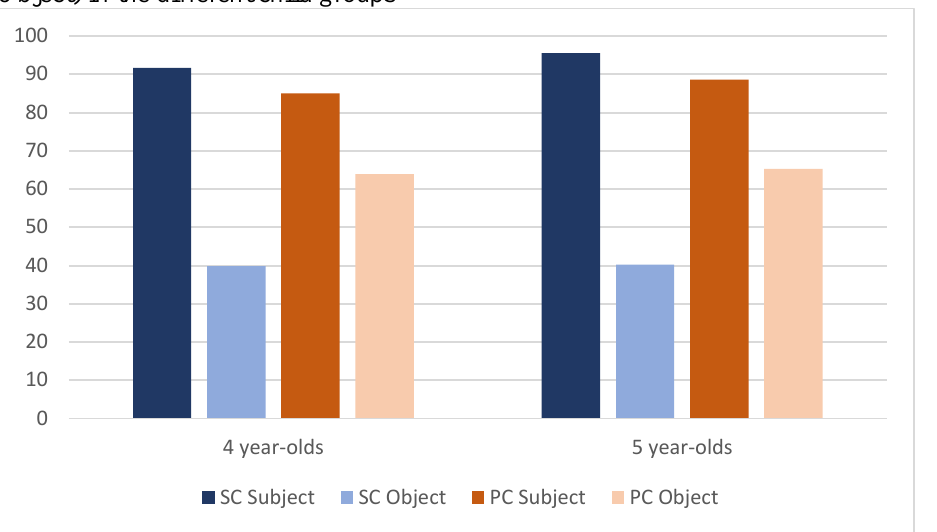
Figure 3. Overall proportion of correct answers for subject standard clefts (SC Subject), object standard clefts (SC Object), subject pseudoclefts (PC Subject) and object pseudoclefts